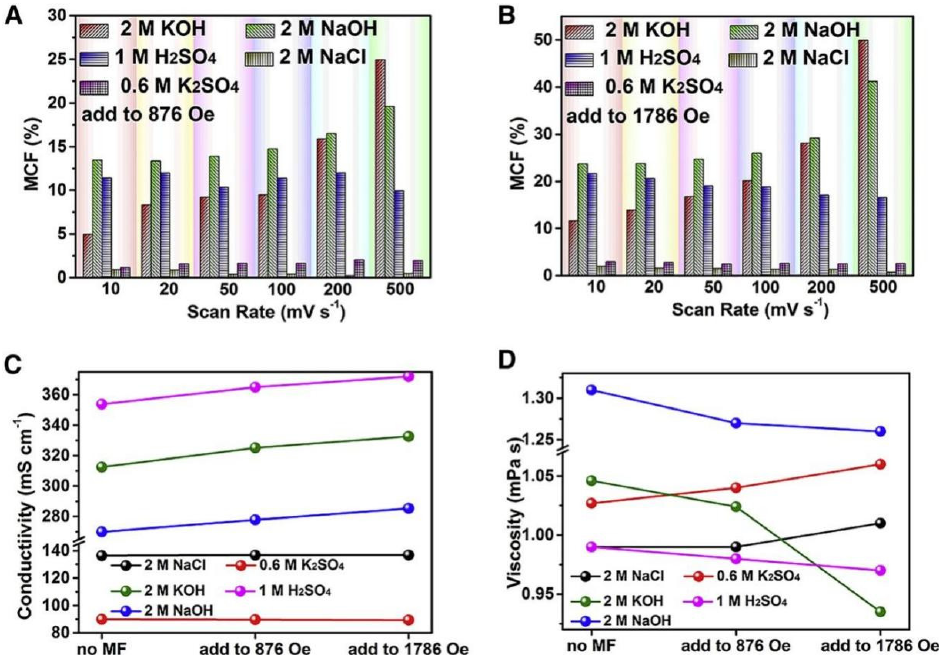
Figure 15. The impact of magnetic field on various aqueous electrolyte’s conductivity, viscosity, and electrochemical properties. The MCF variation with scan rates under the magnetic field of ( A ) 876 Oe, and ( B ) 1786 Oe, ( C ) Variation in the conductivity with magnetic field, and ( D )Variation in the viscosity with magnetic field. Reproduced (modified) from [143] Copyright (2021) with permission from Elsevier.